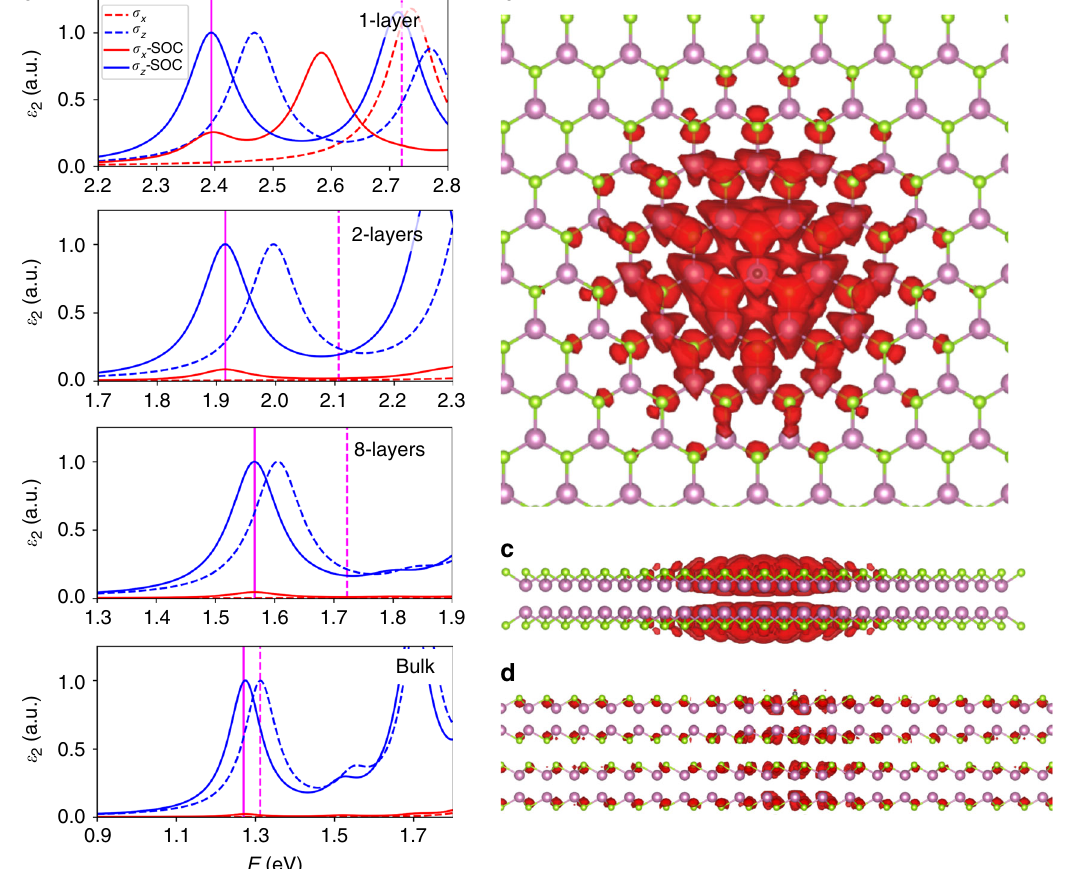
Fig. 5 Optical properties of two-dimensional (2D) InSe. a Optical absorption calculated in the independent-particle approximation for monolayer (ML), bilayer, eight-layer and bulk InSe for in-plane (IP) ( σ x ) and out-of-plane (OP) ( σ z ) polarised light. Solid (dashed) lines are calculations with (without) spin – orbit interaction. b Lateral and c surface density of the wave function of the fi rst excitonic state of ML InSe. d Lateral density of the excitonic wave function of bilayer